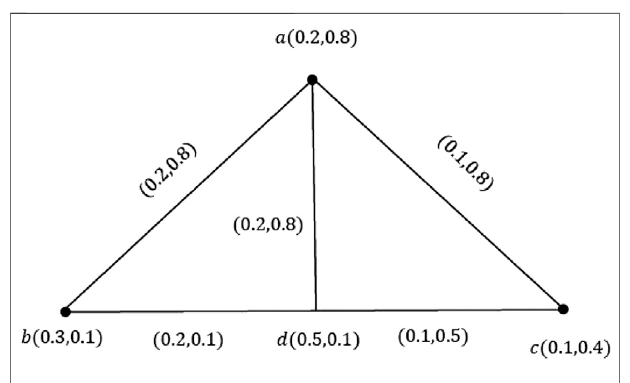
FIGURE 5 | EIS of ζ .